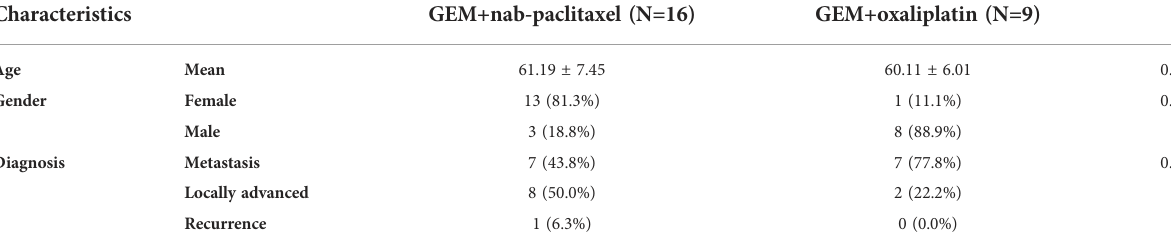
TABLE 1 Baseline characteristics of the 25 patients with unresectable pancreatic cancer.